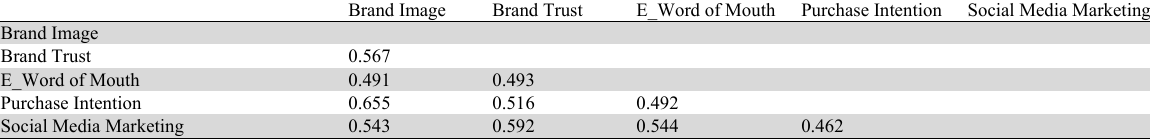
The results of Heterotrait-Monotraint Ratio